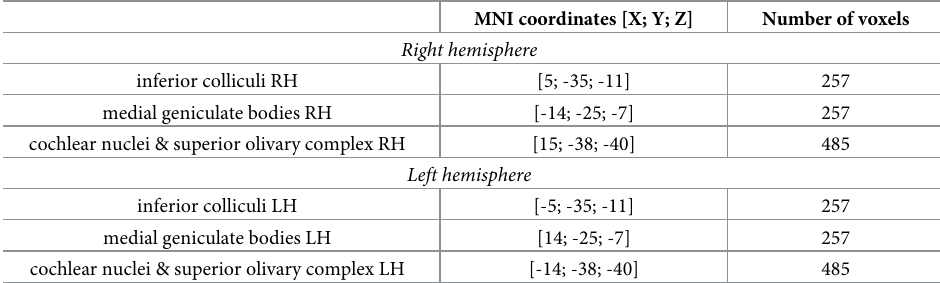
Table 1. MNI coordinates of the